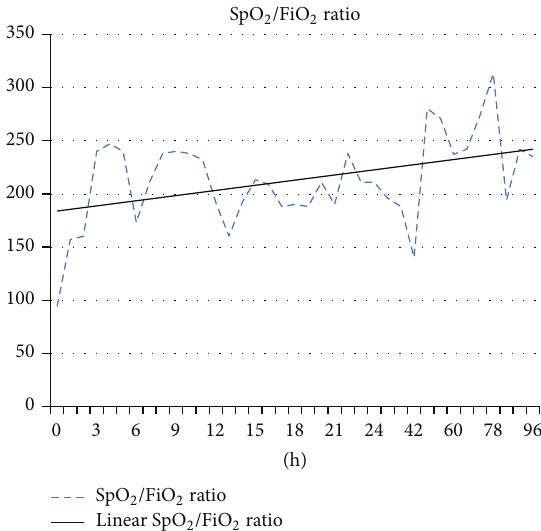
Figure 3: SpO 2 /FiO 2 evolution after helmet CPAP